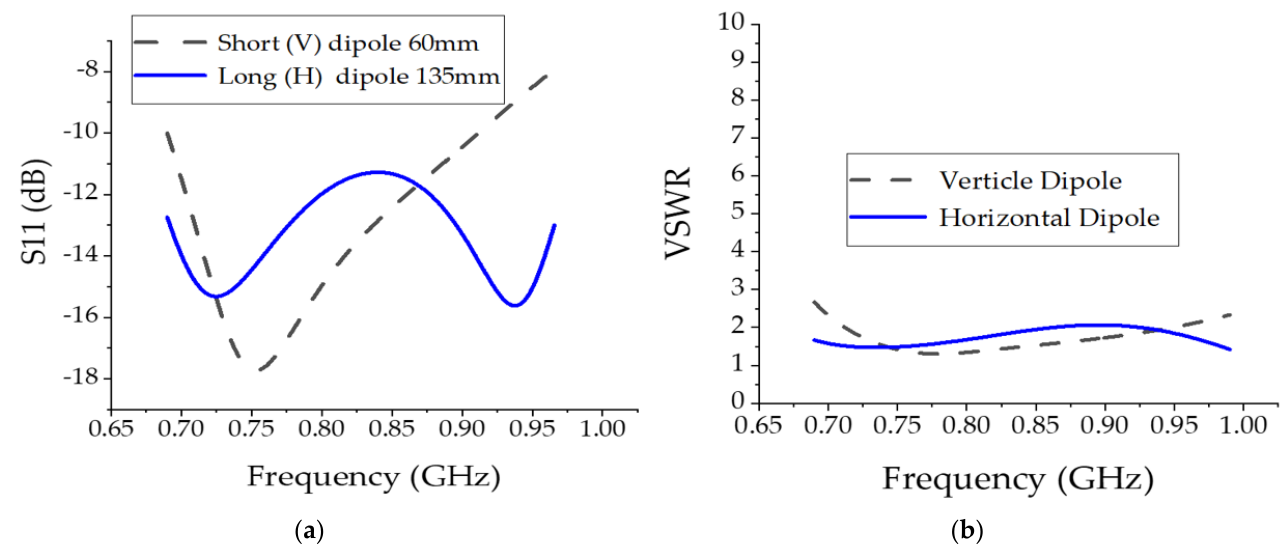
Figure 8. ( a ) The measured return loss of the short V-dipole and long H-dipole. ( b ) VSWR of proposed antenna LBHV.